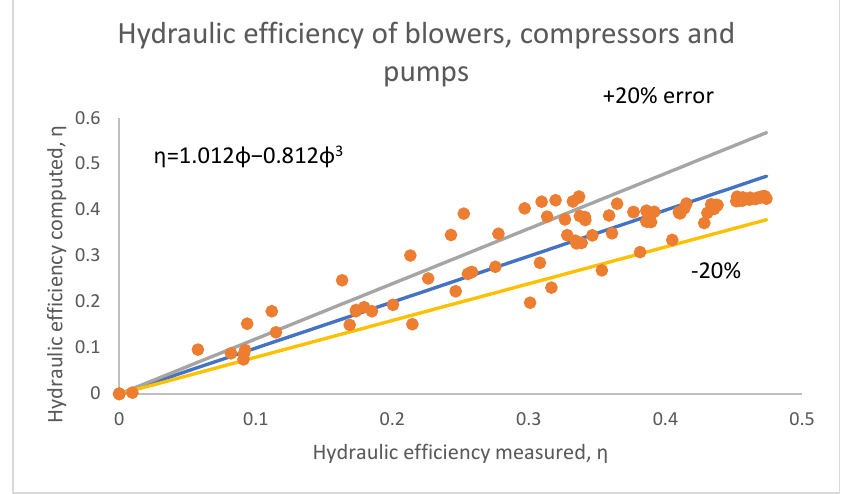
Figure 11. Hydraulic efficiency of peripheral vane impeller machines as estimated by the correla ‐ tion.